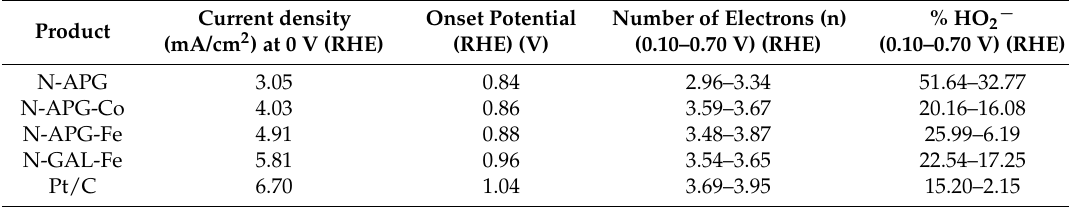
Table 2. Surface area of doped and non-doped apricot catalysts with Fe and Co.